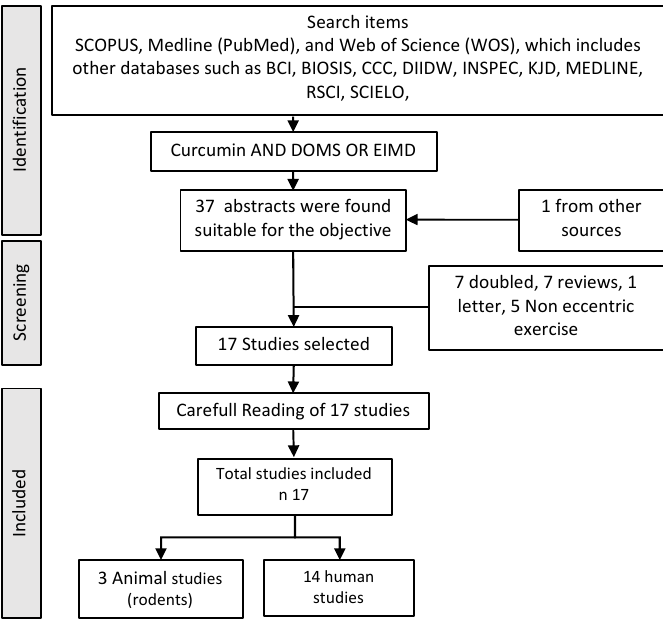
Figure 2. Flow chart used in the bibliographic search in humans and animals.